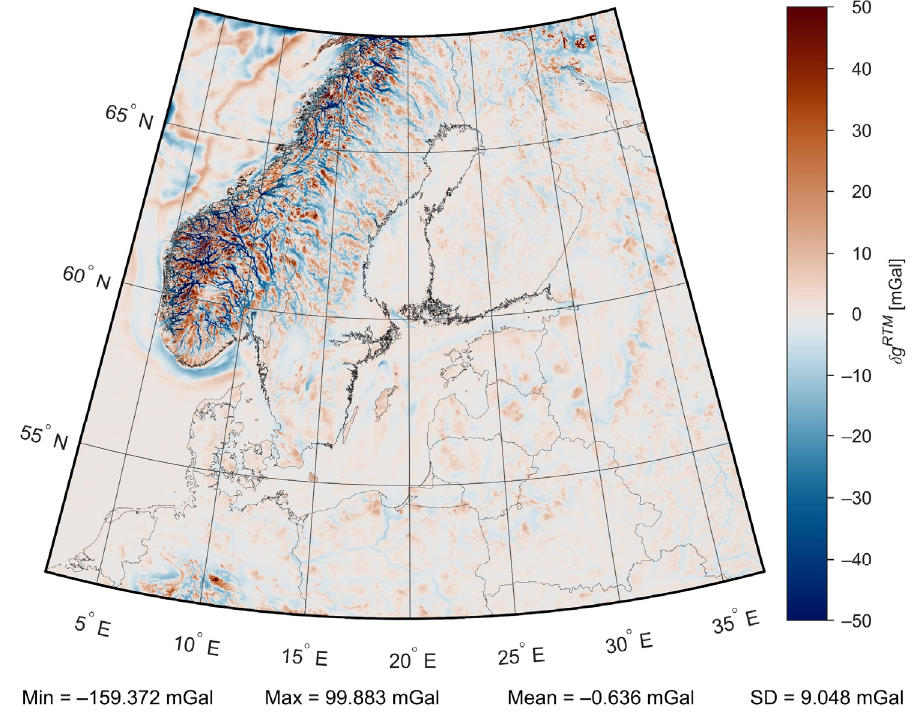
Figure 6. RTM reduction computed by also considering bathymetry information.